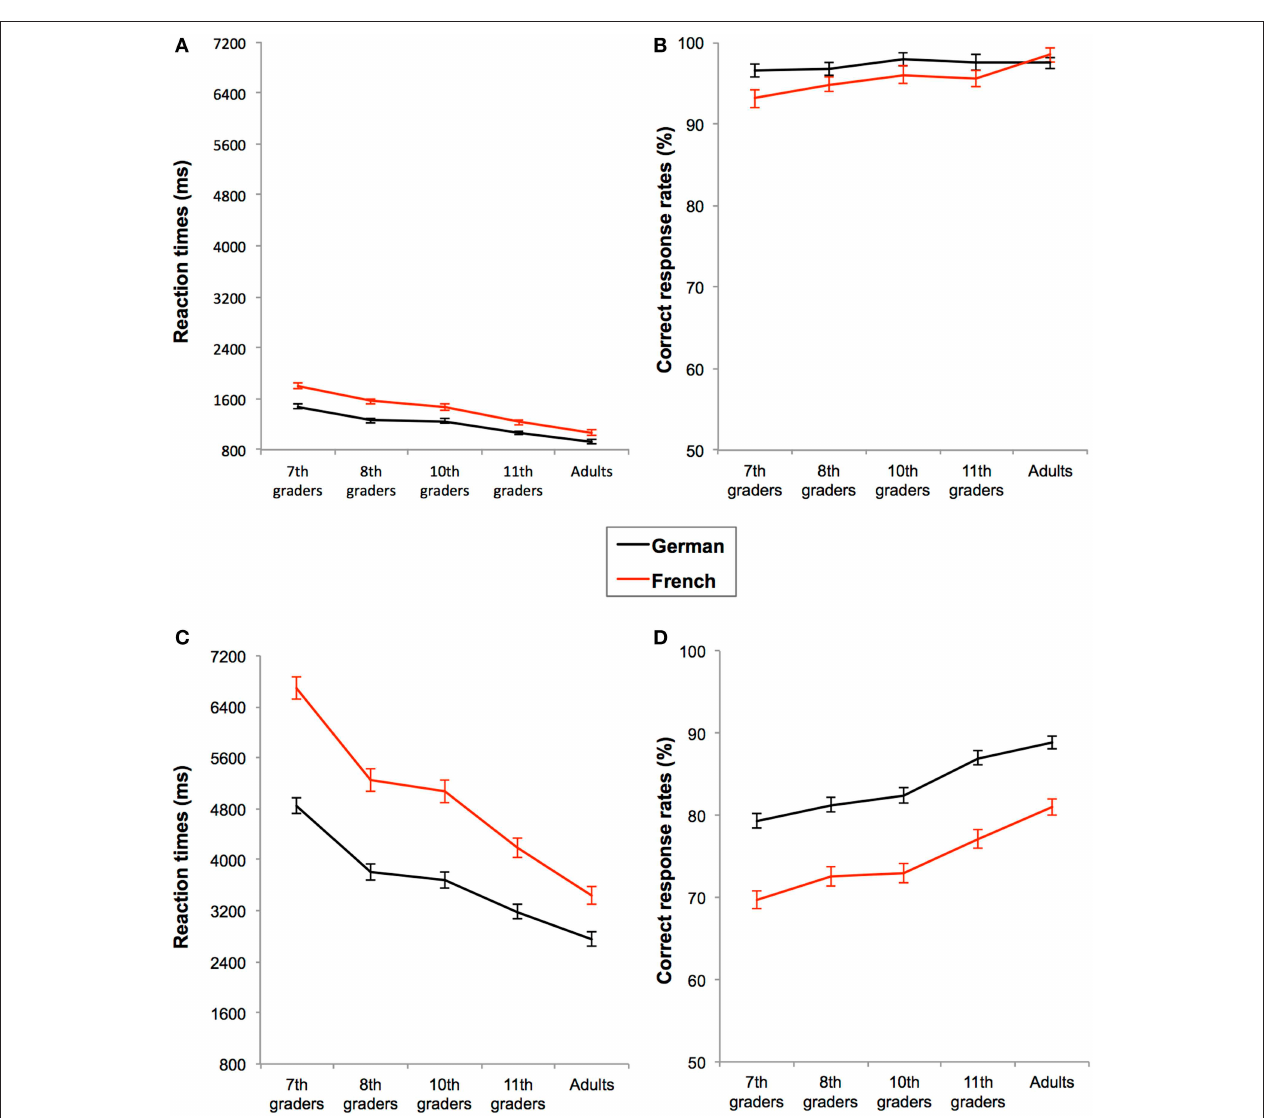
FIGURE 2 | Mean performances for simple additions (A, B) and for complex additions (C, D) in each task language (black line for German and red line for French) as a function of age-group. Performances are measured in reaction times (A, C) and in correct response rates (B, D) . Bars represent standard errors.